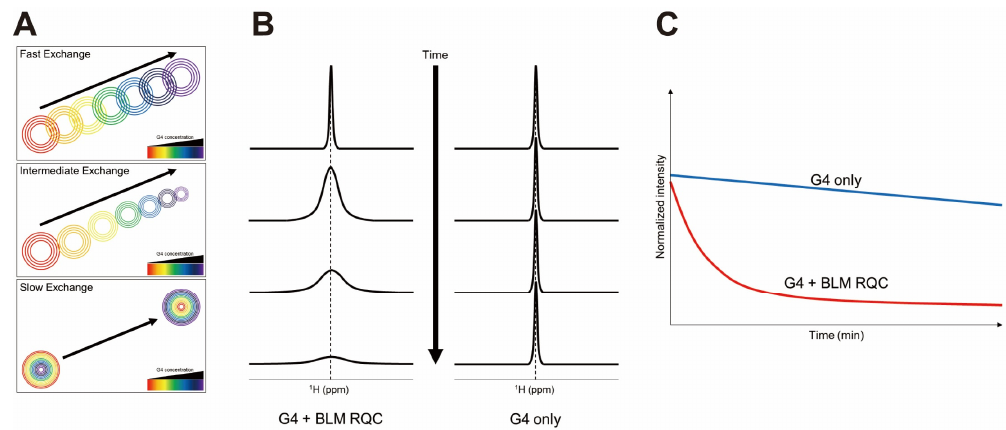
Figure 3. ( A ) CSP patterns with the G4-protein complexes in different exchange regimes on the NMR timescale. Schematic drawings of ( B ) a 1 H imino proton peak in the middle plane of the G4 in an H/D exchange experiment and ( C ) a decay profile of a specific imino proton.